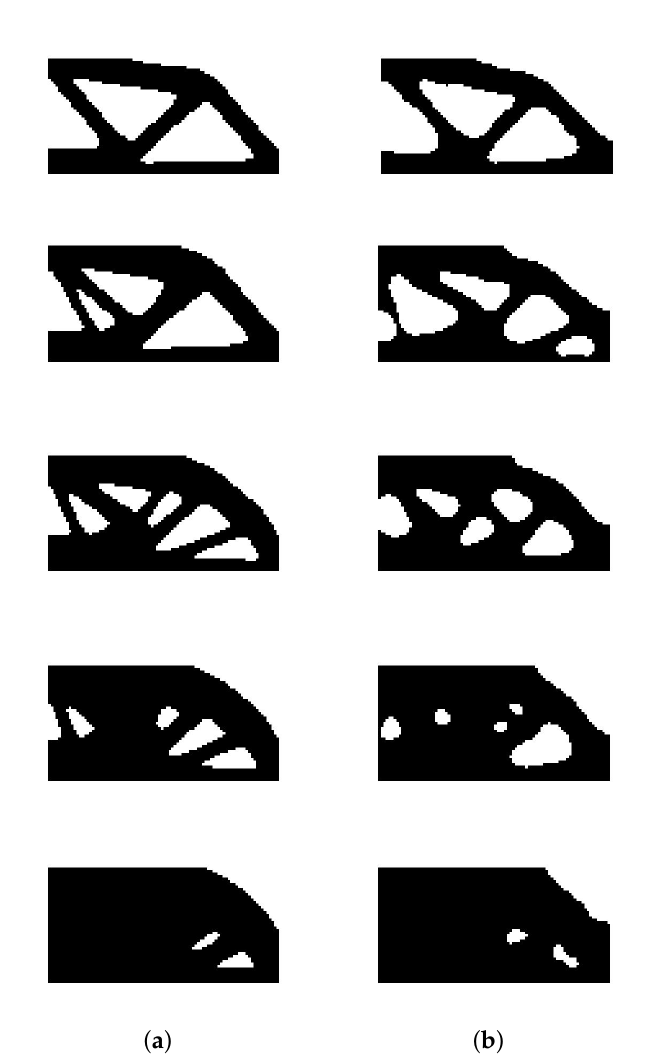
Figure 8. The results for optimized topology of a half-MBB beam in different volume fractions of 0.5, 0.6, 0.7, 0.8, and 0.9. ( a ) Results from the literature. ( b ) Results from the proposed